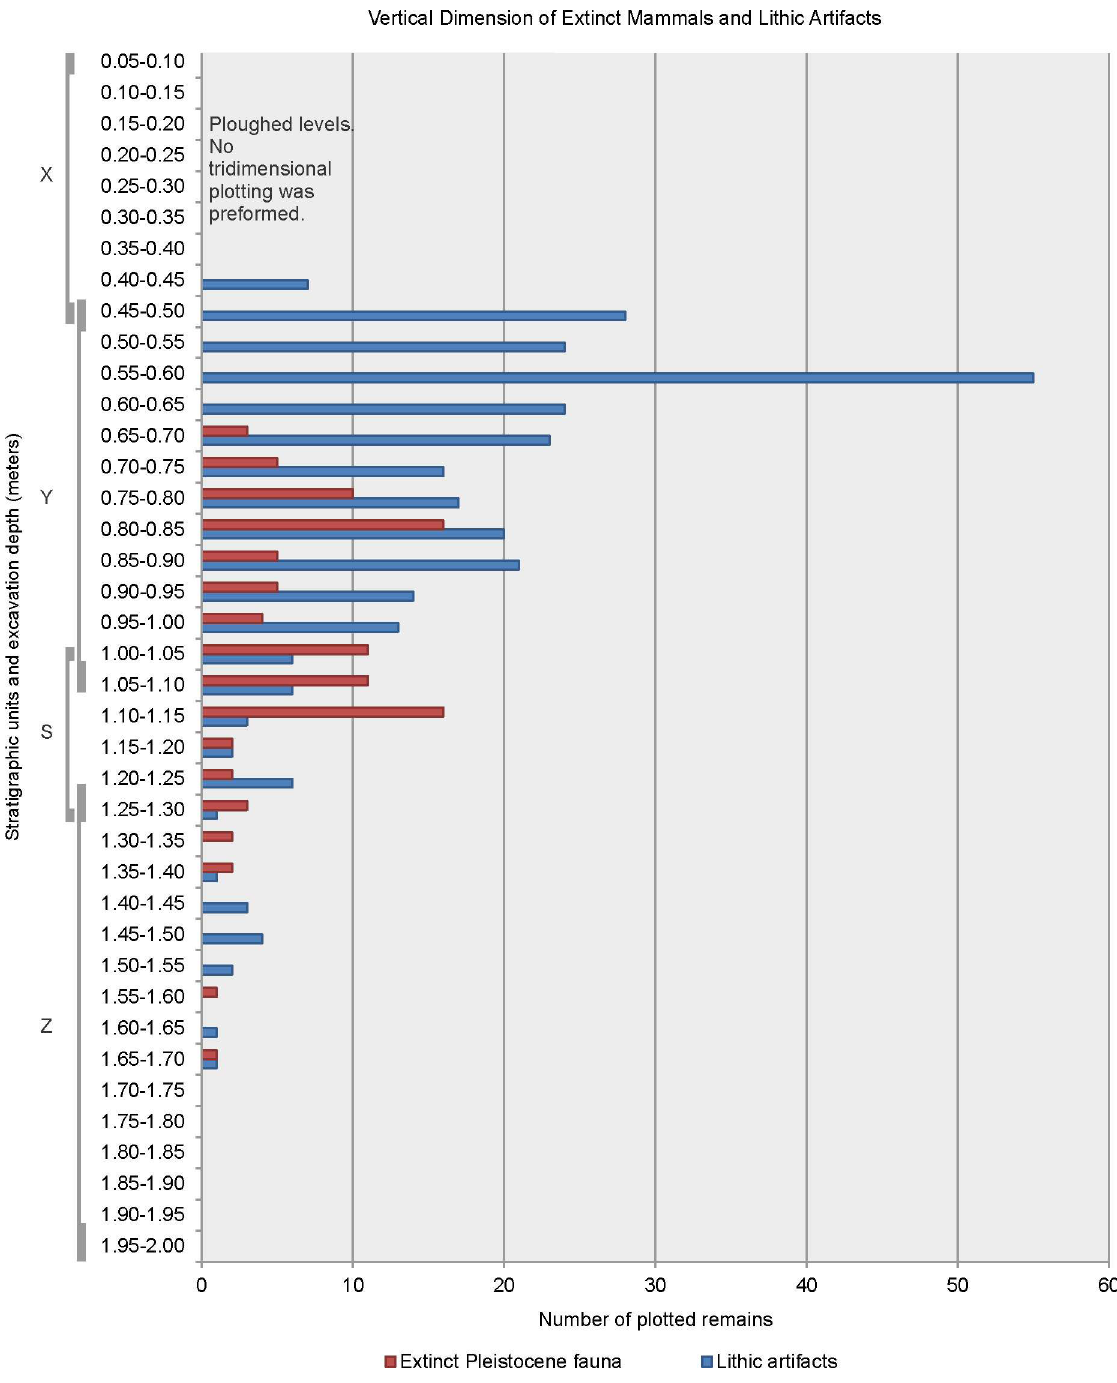
Fig 4. Vertical distribution of extinctPleistocene faunaand lithicartifactsfrom the AS2 site. Calculatedusing the total numberof tridimensional plottedremainsfromthe excavation units